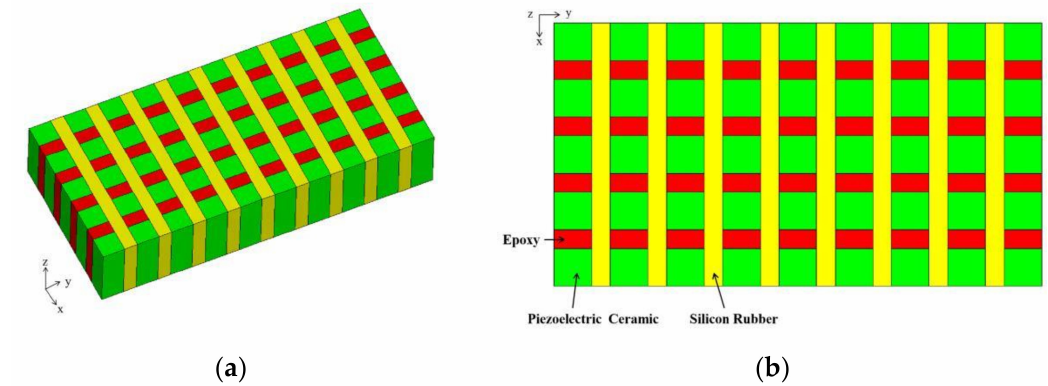
Figure 1. 3D structure diagram ( a ) and 2D diagram ( b ) of modified 1-3 piezoelectric composite